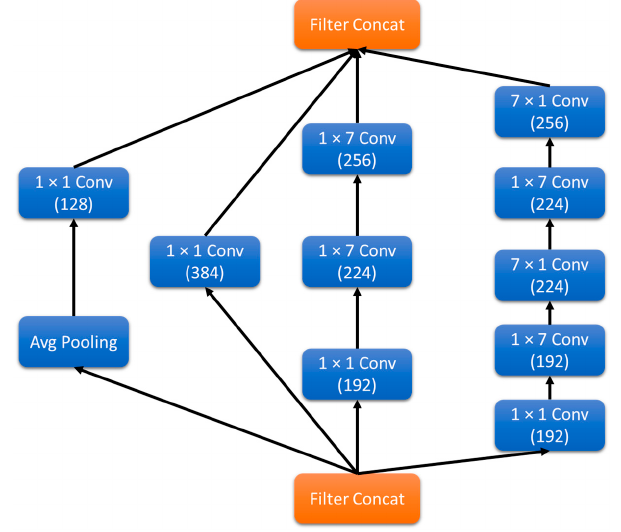
Figure 5. Inception module (Inception-v3).